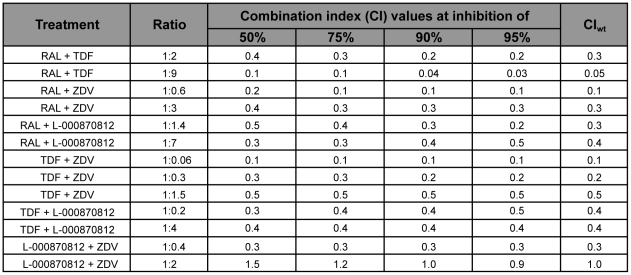
Evaluation of drug-drug interactions against XMRV at 50%, 75%, 90%, and 95% inhibition.Combination Index (CI) values were determined for a mutually exclusive interaction using CalcuSyn program, where CI <1 indicates synergism, CI = 1 indicates additive effect, and CI >1 indicates antagonism. Weighted average CI value (CIwt) was assigned as [CI50 + 2CI75 + 3CI90 + 4CI95]/10. RAL, raltegravir; TDF, tenofovir disoproxil fumarate; ZDV, zidovudine.